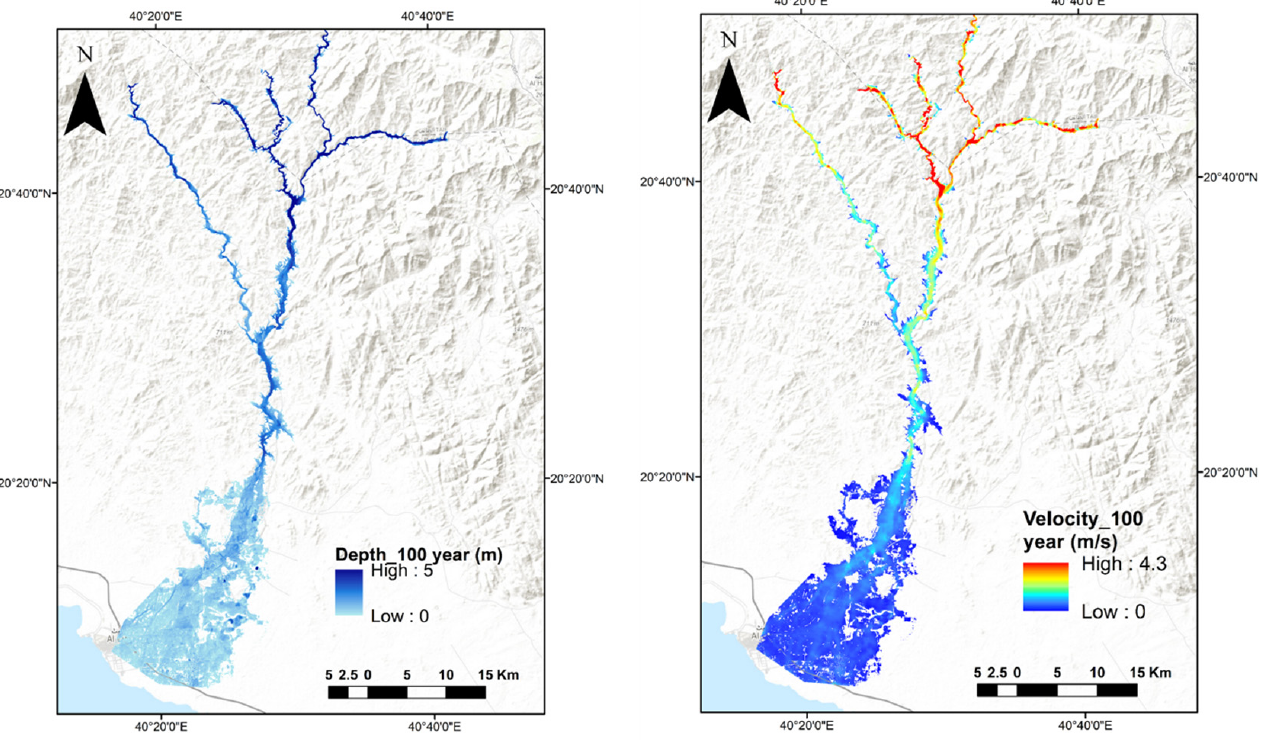
Figure 9. Water runoff depth and velocity from a 2D HEC-RAS model with a 100-year return period.